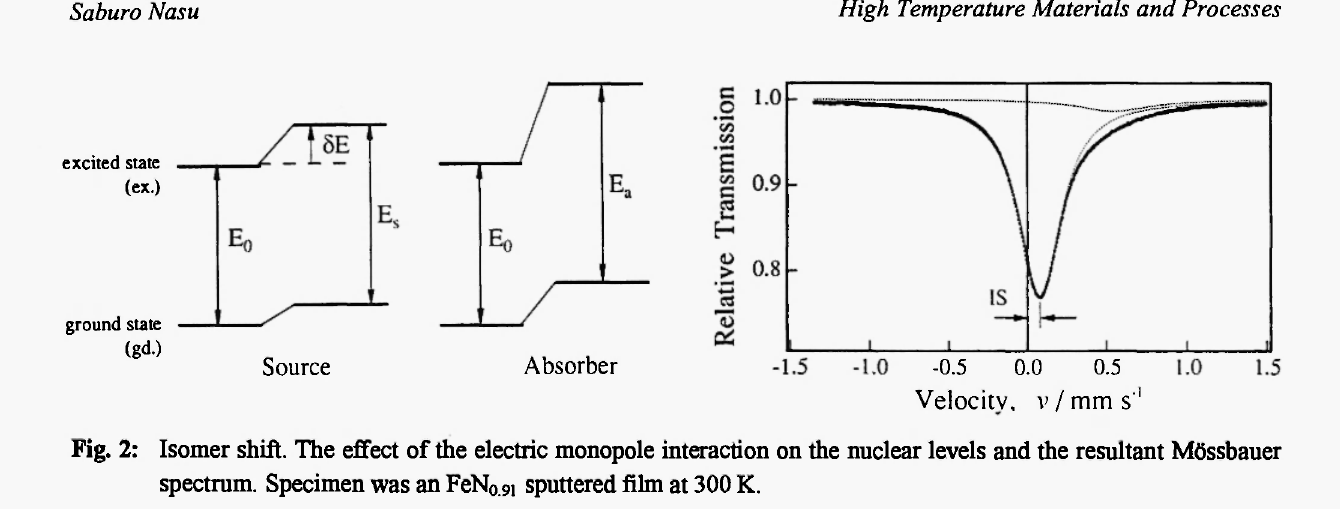
Isomer shift scale for 57 Fe (14.4 keV) in reference materials /10/. Source and absorber at room temperature, SNP =